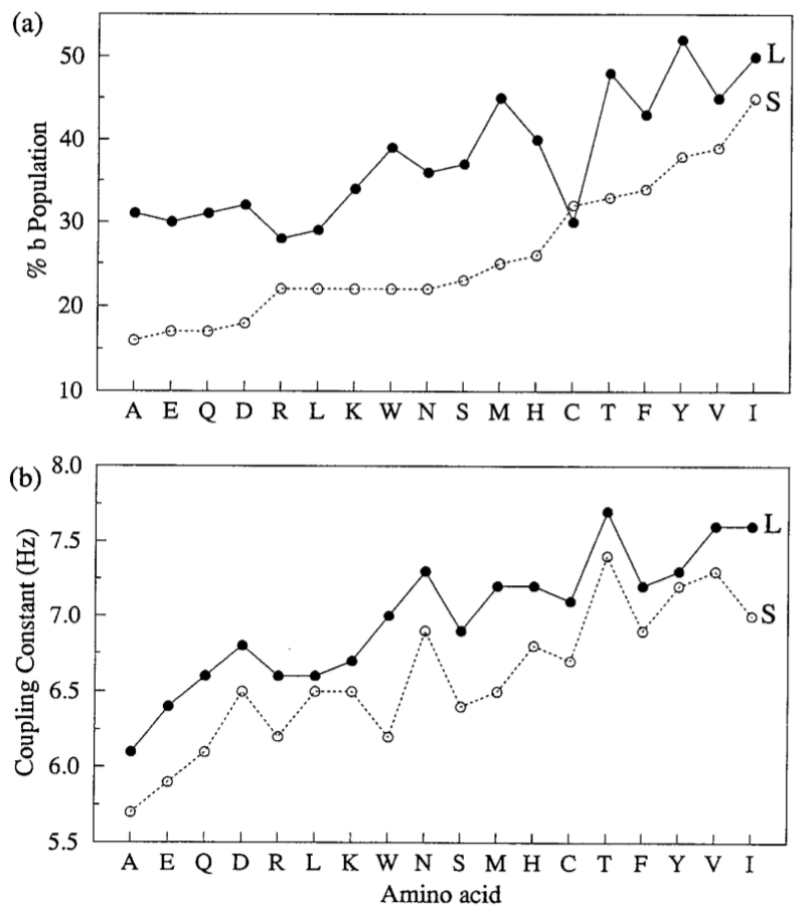
Figure 4. ( a ) Population of the extended β-region (b-region in Figure 2) by the indicated amino acid residue in the presence of an L-type (F, H, I, TV, W, Y) or S-type (remaining amino acid set, G excluded) upstream neighbor. ( b ) Corresponding average 3 J(H N H C α ) values (Equations (6) and (7)). Taken from [61] with permission, 1997, Academic Press.